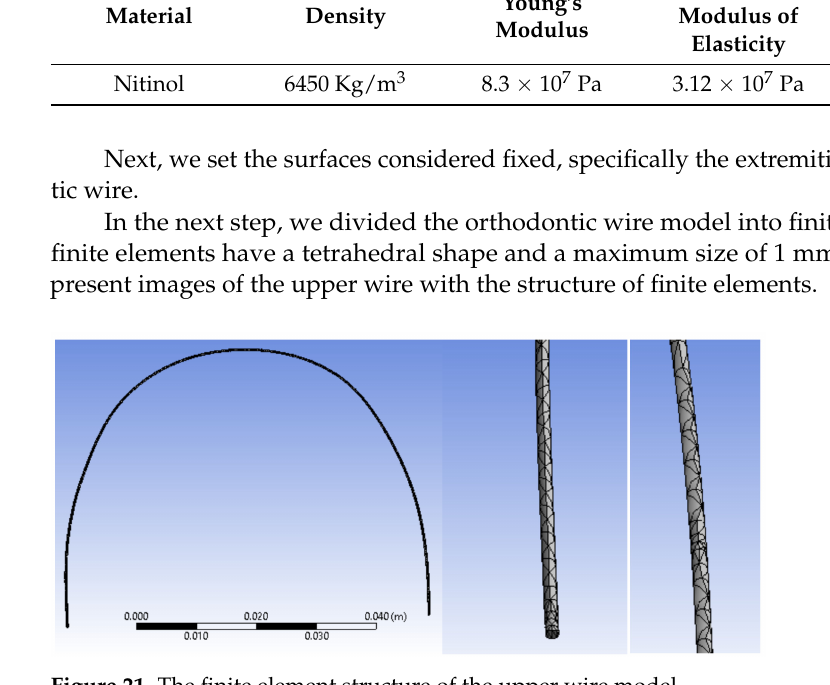
Figure 21. The finite element structure of the upper wire